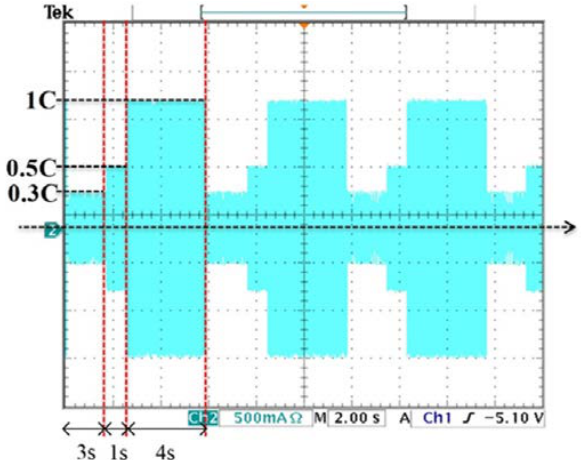
Figure 16. The measured loading current waveforms of the proposed high-frequency AC electronic load using the programmable function.